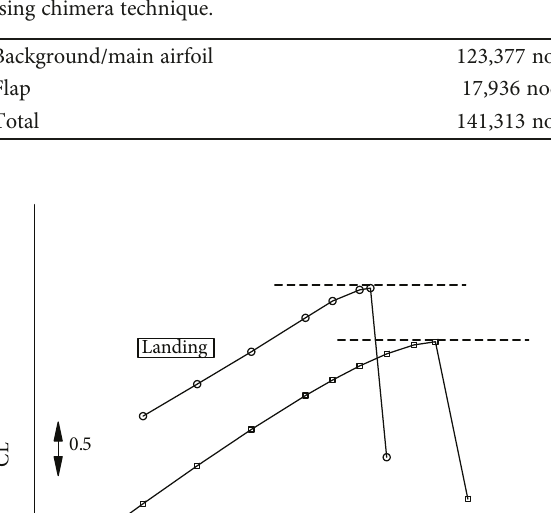
Table 5: Grid dimensions for the 2D CFD performance evaluation using chimera technique.